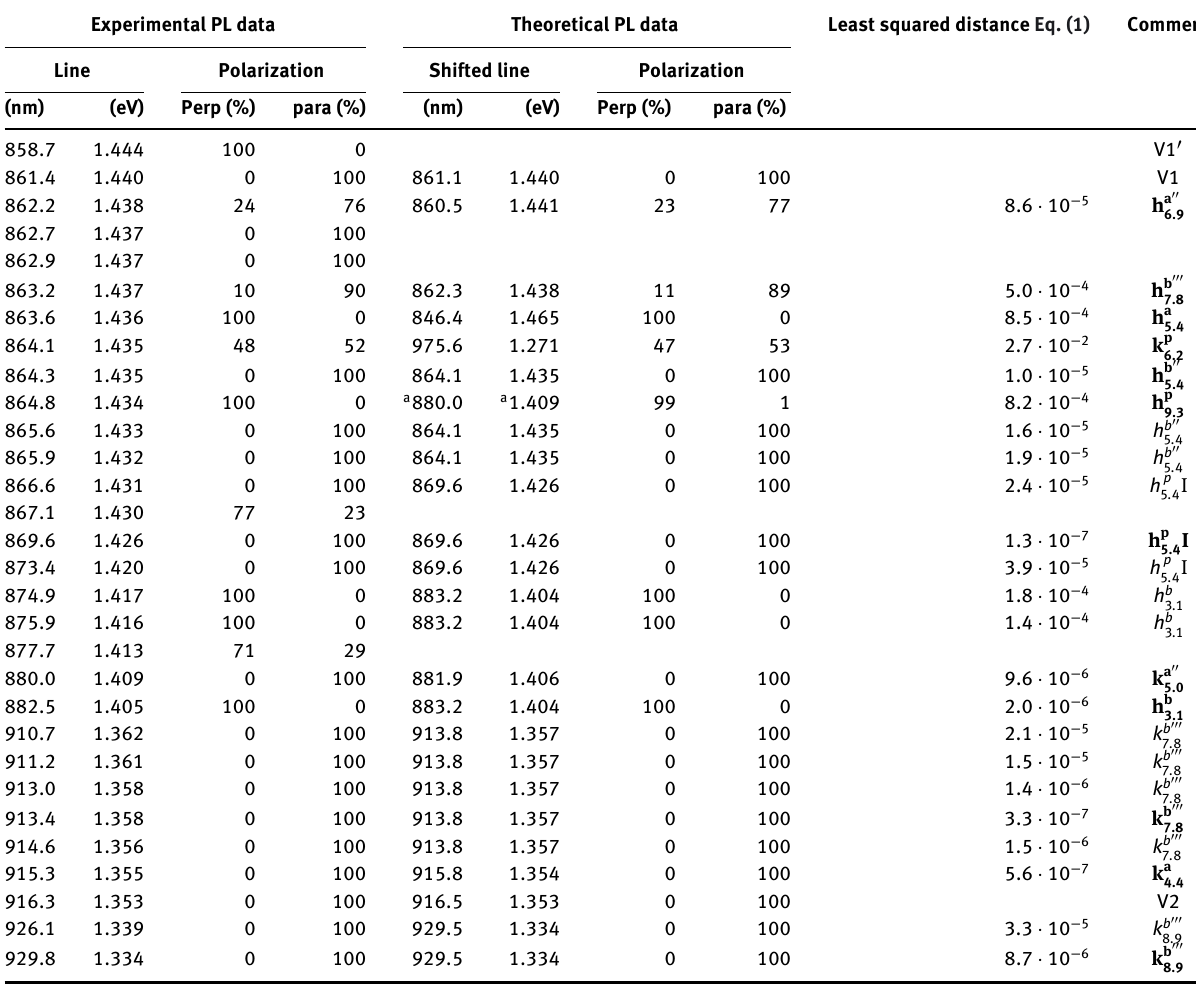
Table 5: Summary of the identified modified vacancy configurations. In this table, the theoretical HSE ZPL results have been shifted to align with the experimental isolated silicon vacancy results for easier comparison. This means a shift of 64 meV for the h configurations and 70 meV for the k configurations. Unshifted values are presented in Tables 3 and 4. The assigned configurations are marked in bold. When multiple configurations match an experimental line, the configuration with the smallest least squared is